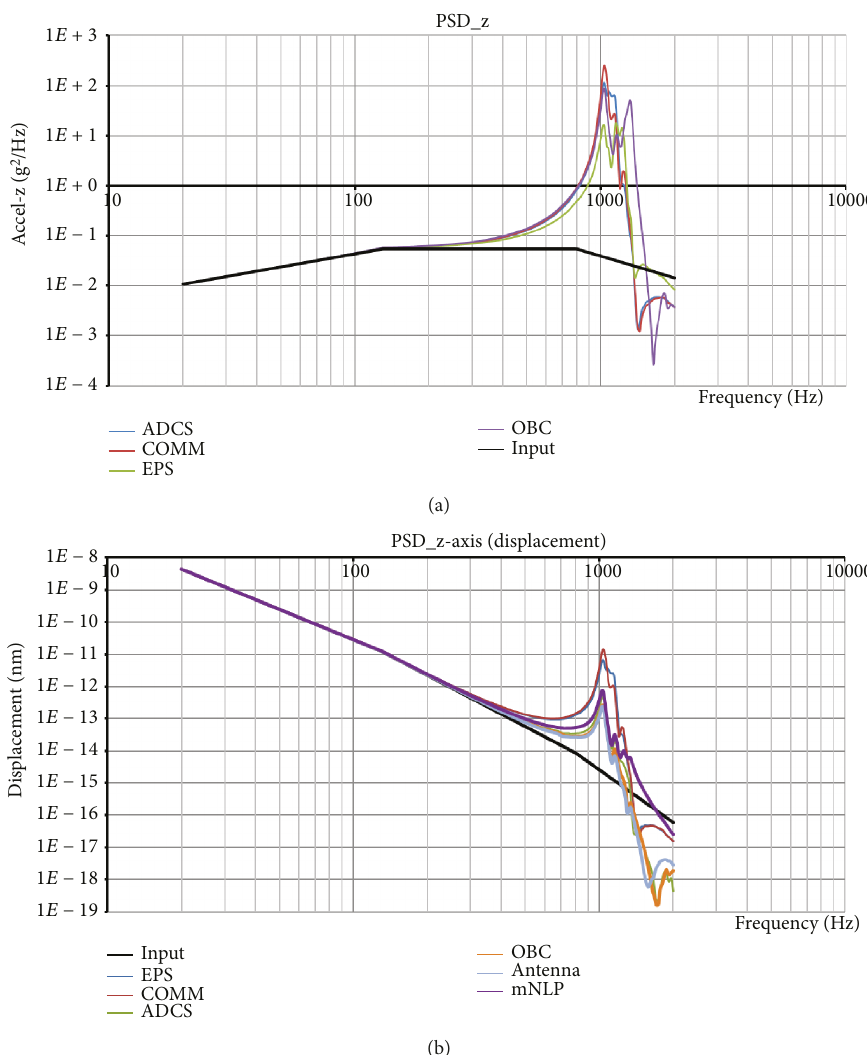
Figure 10: PSD results: (a) acceleration and (b) displacement.